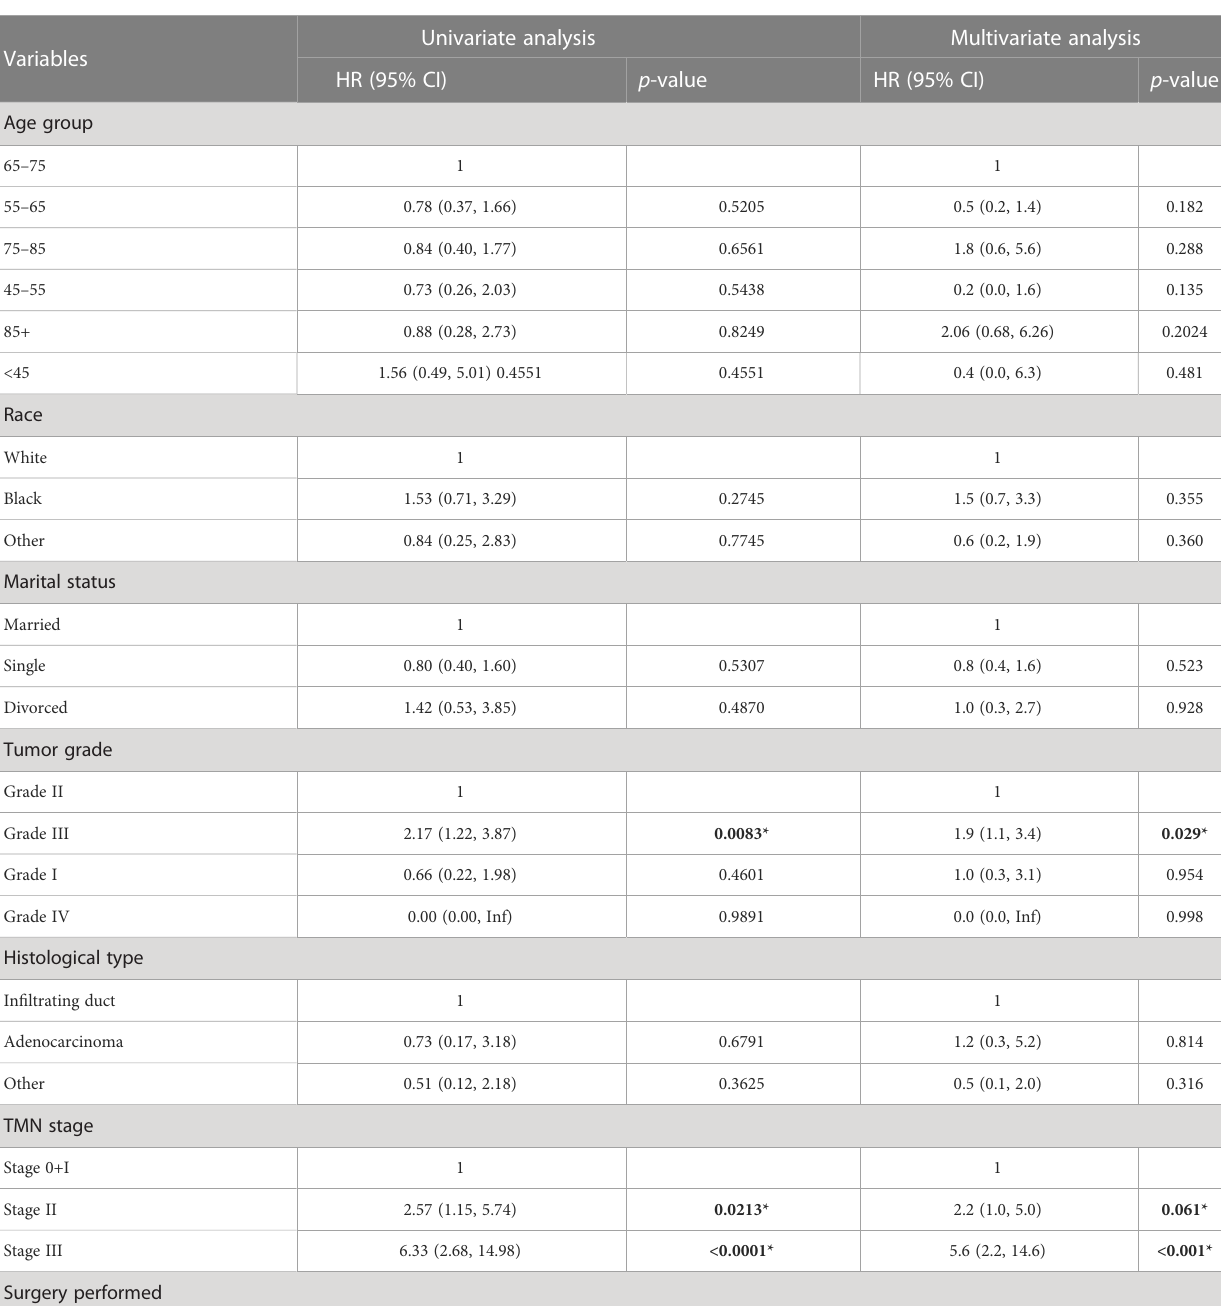
TABLE 3 Univariate and multivariate analysis of cancer-speci fi c